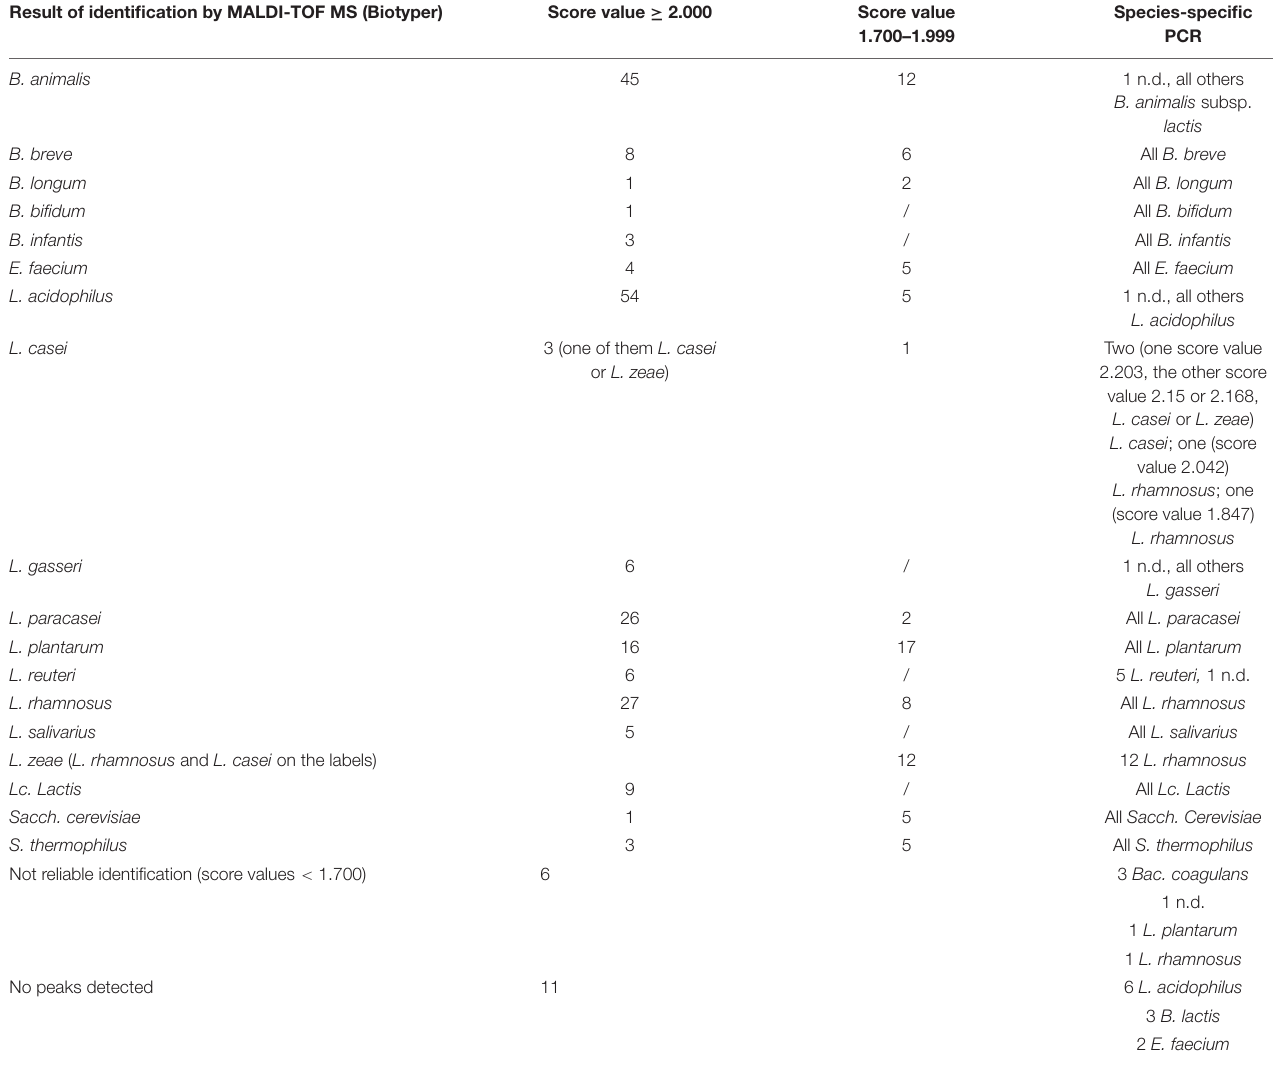
TABLE 2 | Overview of the validation of MALDI-TOF MS (Biotyper) identification of 292 isolates (three isolates per labelled strain) from 17 dietary supplements (1–17) by PCR. Result of identification by MALDI-TOF MS